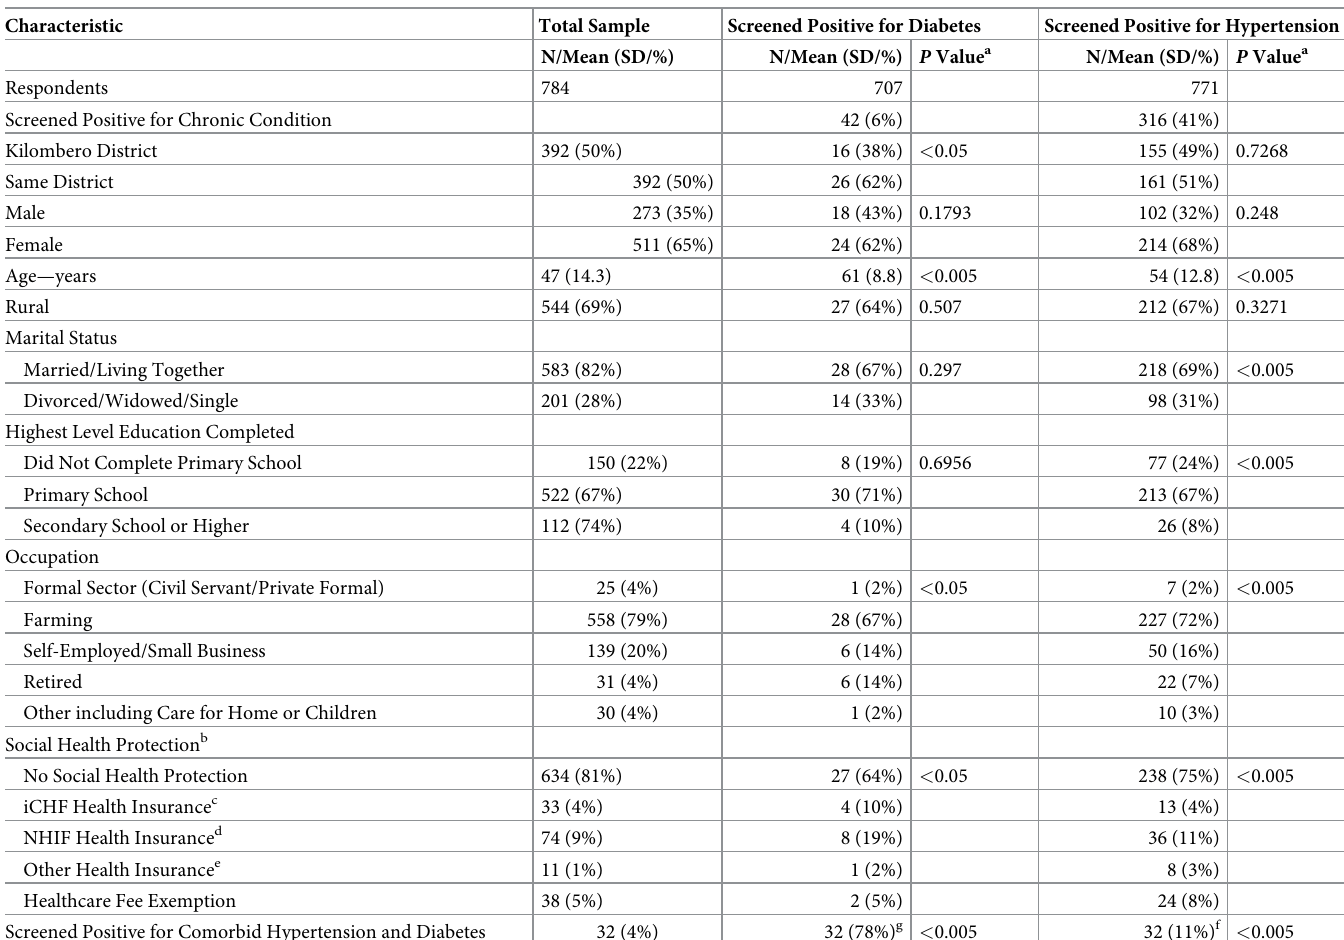
Table 1. Baseline characteristics of study